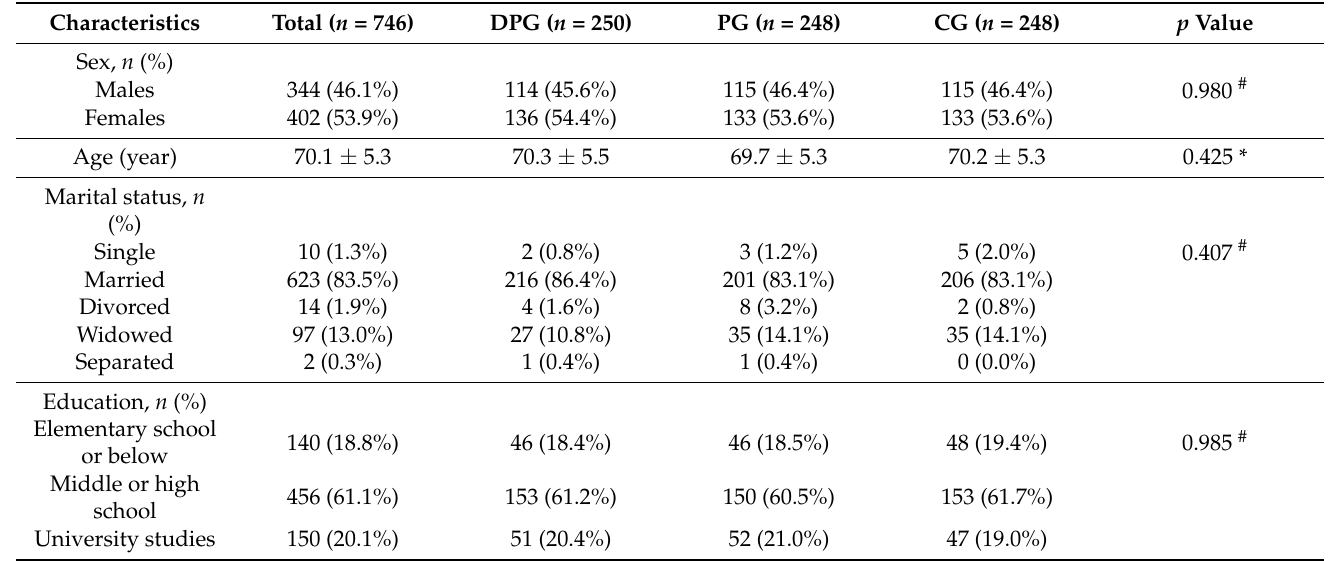
Figure 3. Flow chart of participants through recruitment and follow-up. The baseline characteristics of 746 participants are presented in Table 1. Mean age of the participants was 70.1 ± 5.3 years, and 46.1% were males. There were no significant intergroup differences. Table 1. Characteristics of participants at